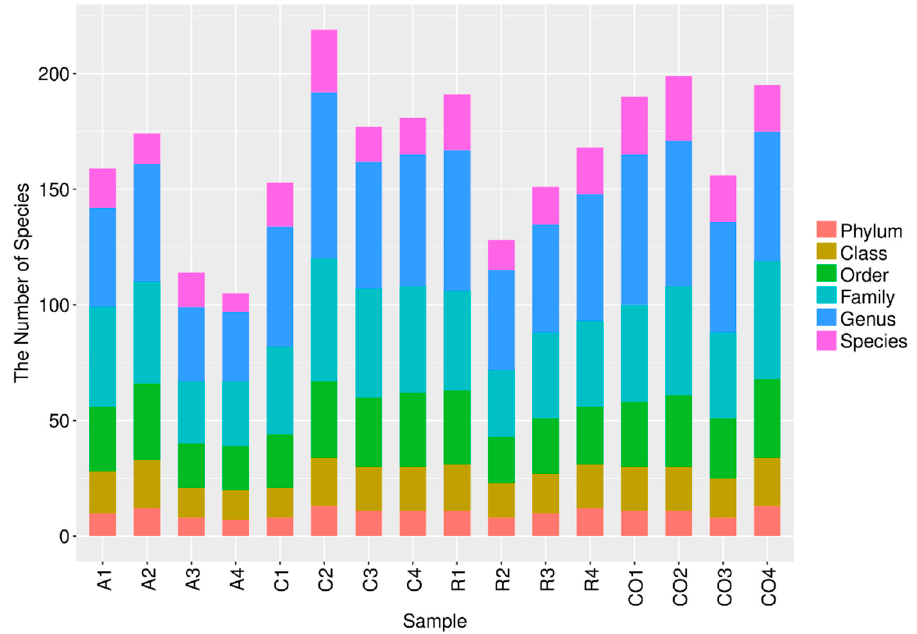
Figure 4. Microbial populations at each classification level. Note: The abscissa depicts the sample name, and the ordinate shows the number of microbial groups in each of the six classification levels, including the classification levels of phylum, class, order, family, genus, and species. (A: alfalfa, C: cornstalk, R: rice straw, CO: control).